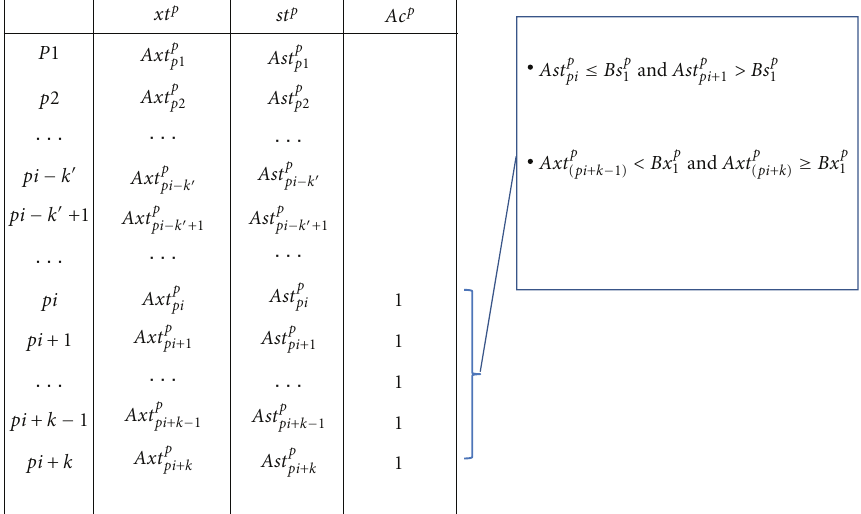
Figure 1: Find the first zone ( ej = 1) from the order of the unknown dataset A at Case I. According to the score and rank, those two values of the objects were defined as the upper-bound and lower-bound of this region, respectively. A zone of “1” is used to define some of the objects that are between pi and pi + k . Therefore, we defined the zone of the object as { Ac